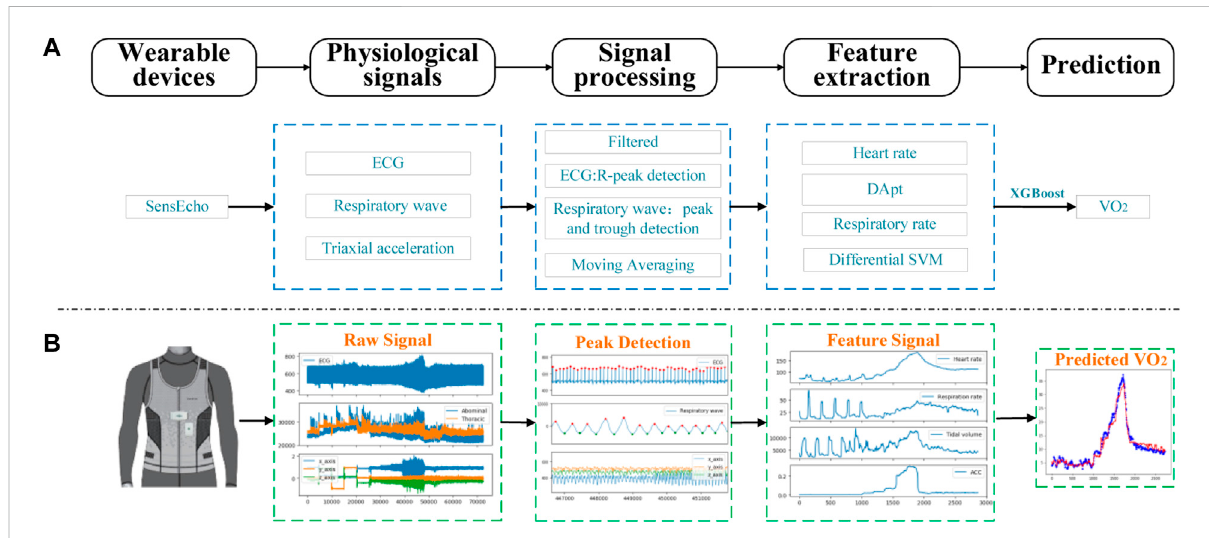
FIGURE 2 Theprocessofsignalacquisition,preprocessingandestimationwithSensEchowearabledevice. (A) A fl owchartoftheentireexperiment. (B)